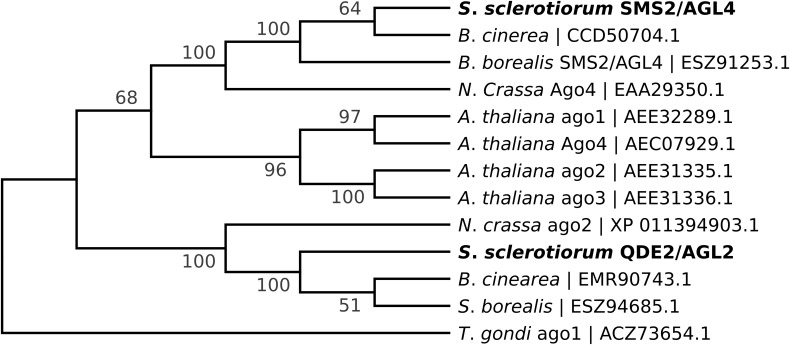
Phylogenetic analysis (Maximum Likelihood tree) of agl-2 and agl-4 genes depicting the relationships between the protein sequences from S. sclerotiorum (in bold), along with their orthologs in B. cinerea, S. borealis, N. crassa and Arabidopsis thaliana. The Toxoplasma gondii agl-1 amino acid sequence was used as an outgroup. Bootstrap consensus was calculated based on 100 bootstrap replicates using Mega 7.0 (Kumar et al., 2016).